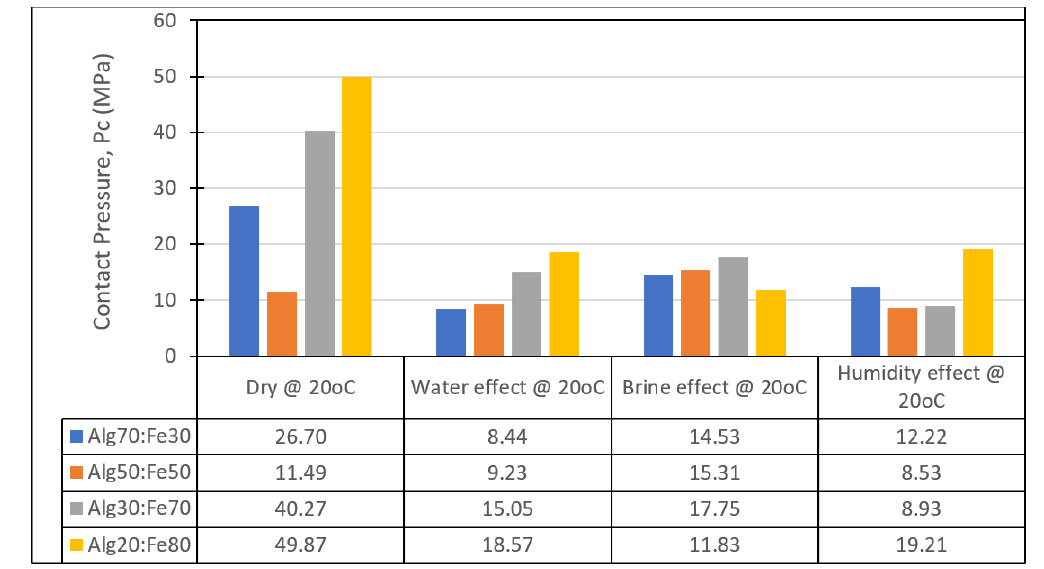
Figure 19. Effect of water, salt, and humidity on capsule compressive strength. Table 3. Capsule test samples weights before and after